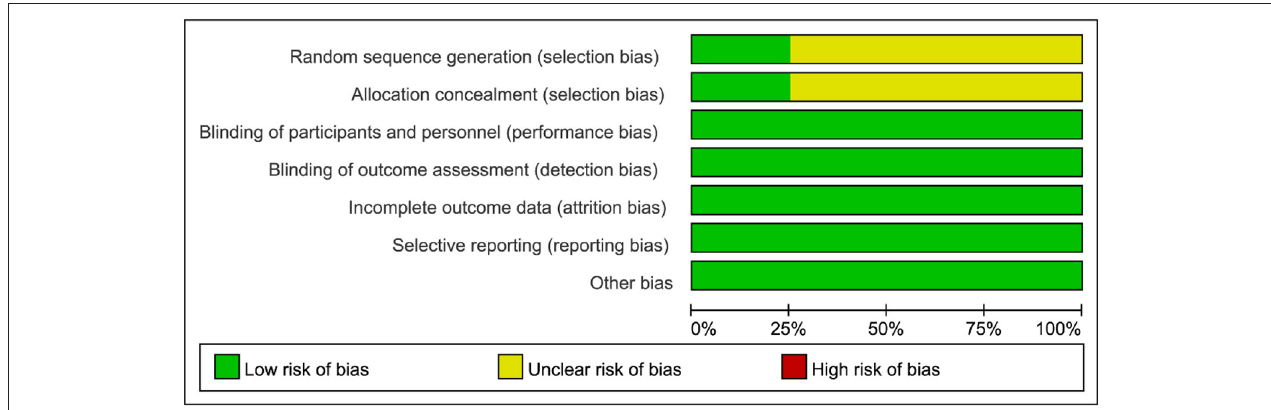
FIGURE 2 | Cochrane Collaboration Risk of Bias Graph of assessment of the quality of